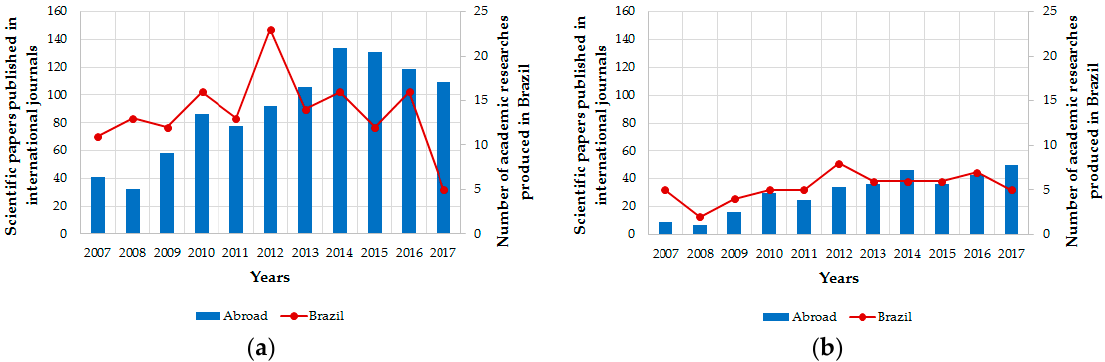
Figure 1. Number of scientific publications in Brazil and abroad found through the search protocols ( a ) Protocol 1: Utilization AND water AND (pluvial OR rain); and ( b ) Protocol 2: Utilization AND water AND (pluvial OR rain) AND (domest * OR residenc * OR edifica